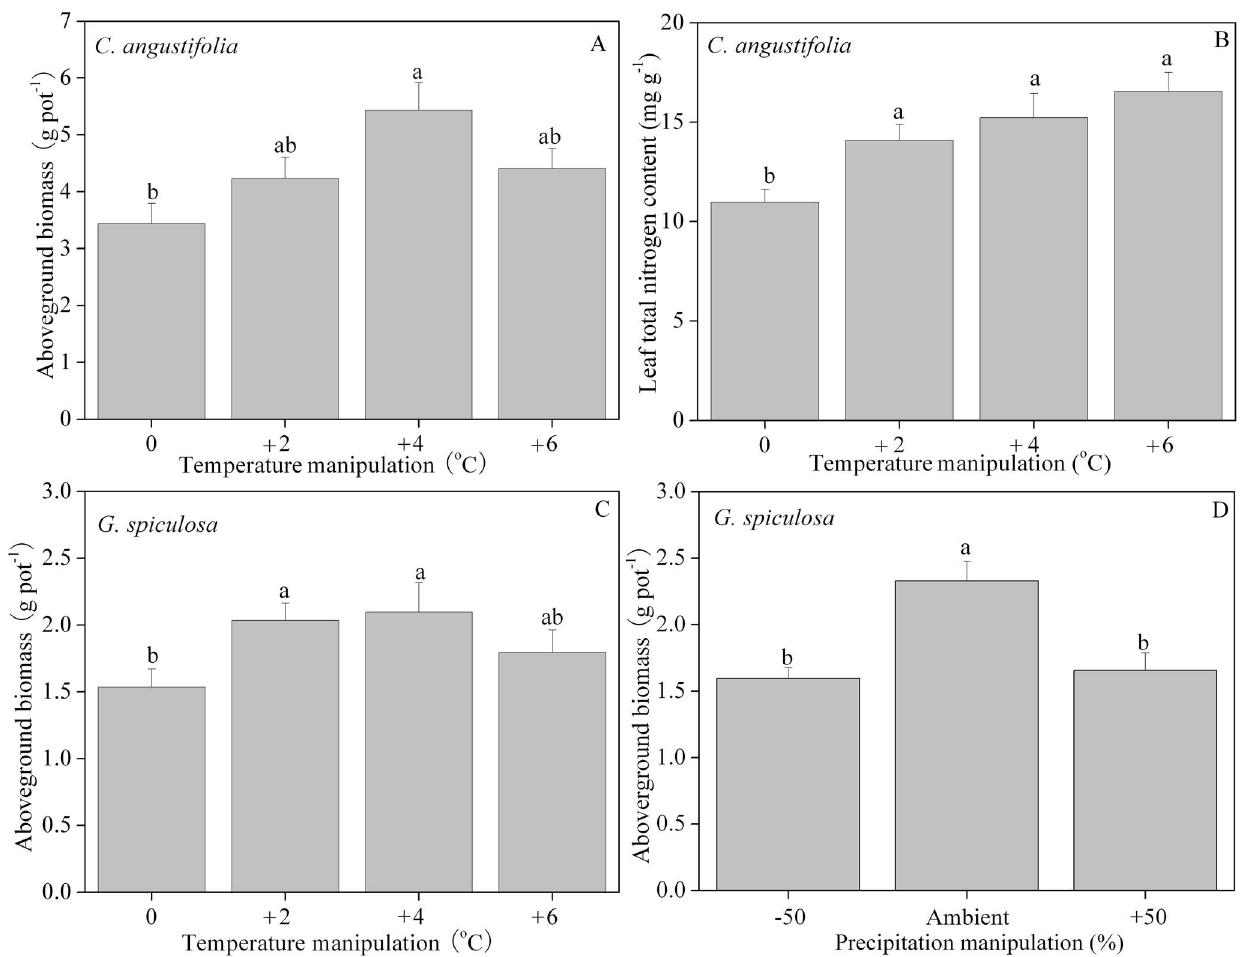
Figure 6. Aboveground biomass (A), leaf total nitrogen (B) of C.angustifolia , and aboveground biomass of G.spiculosa (C, D) after harvest. Different letters shared by the bars indicate significant differences ( p , 0.05) between temperature or precipitation manipulations. The error bars represent means 6 1 standard error.